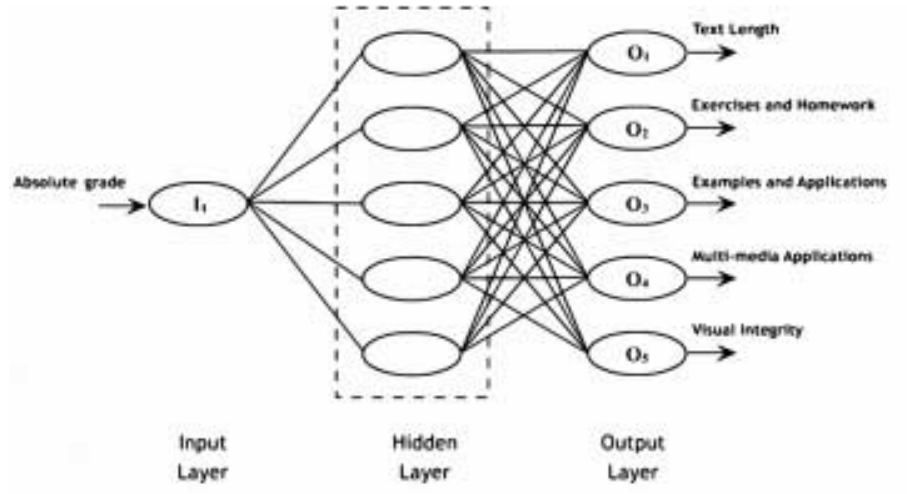
Figure 2. Typology of back-forward neural network model.